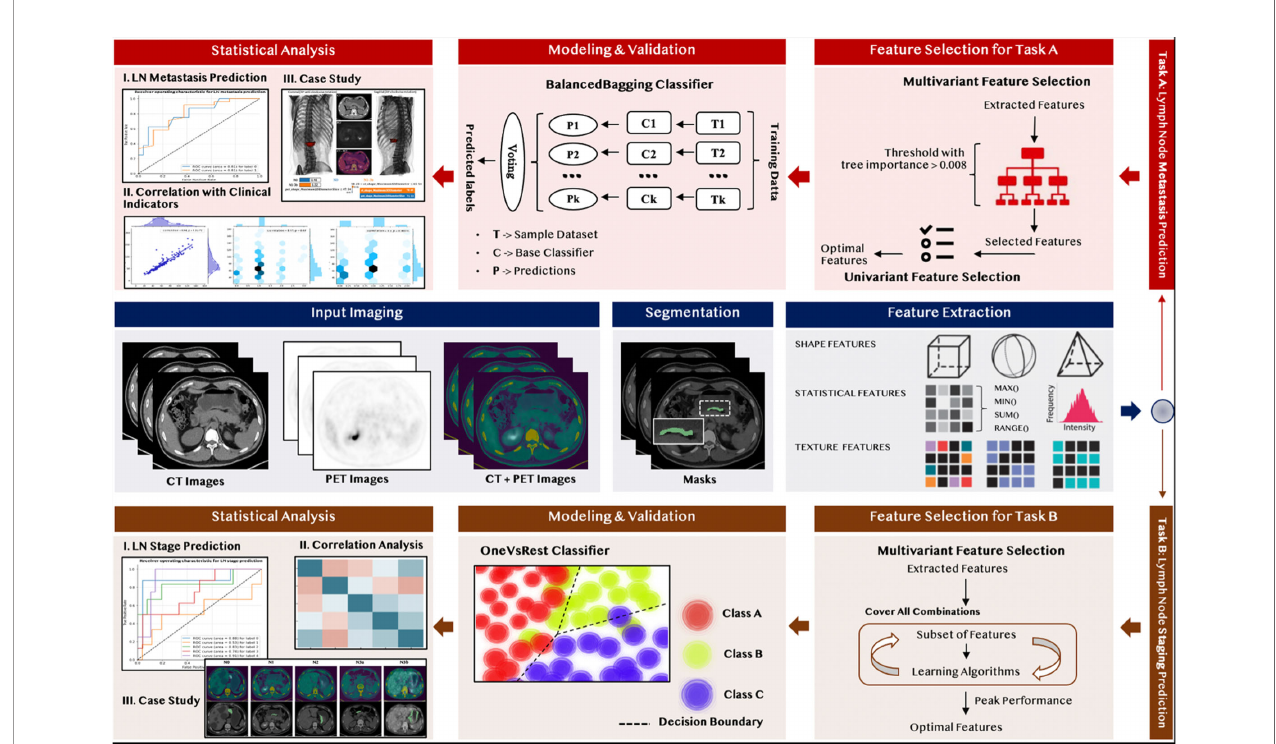
FIGURE 1 | Radiomic fl owchart for the prediction of LNMs (task A) and the N stage (task